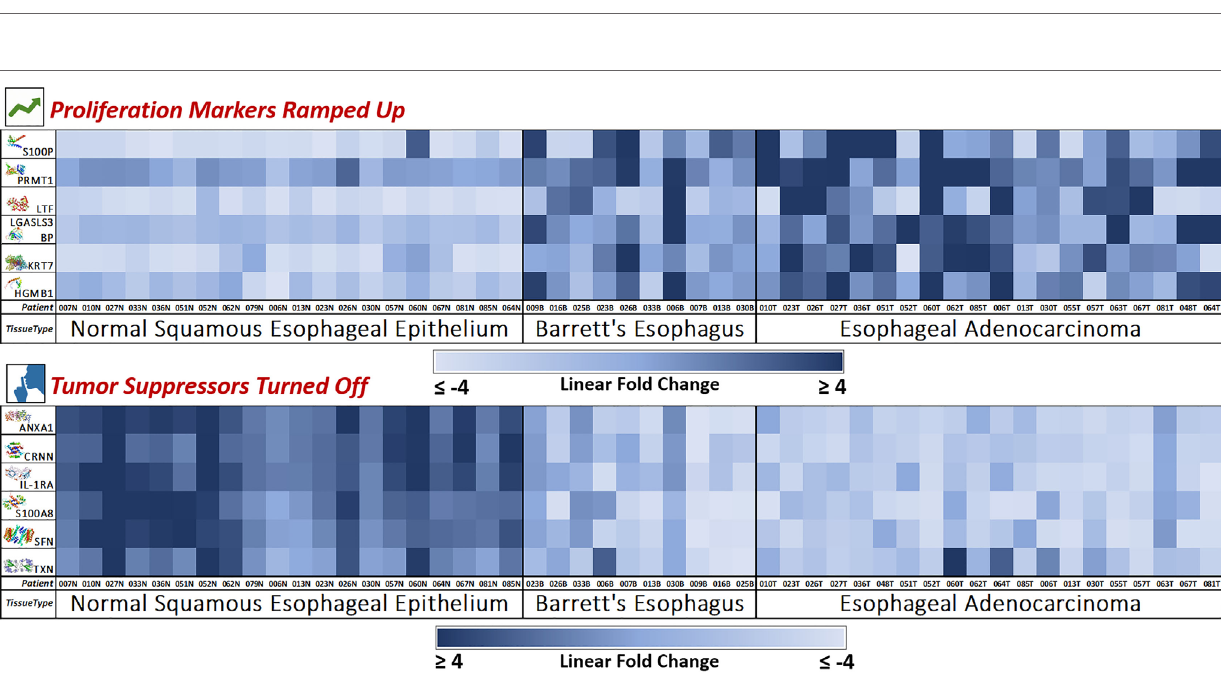
7 Frontiers in Oncology |